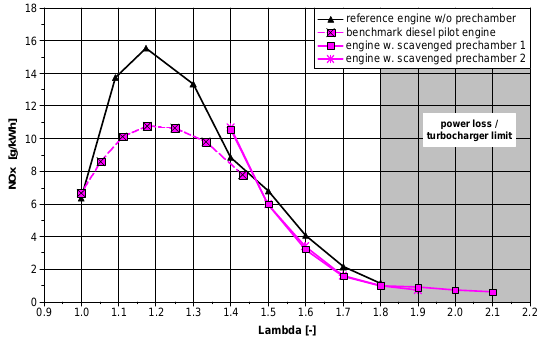
Fig. 19. Raw NO x emissions for the operating point 2 (2000 rpm/220 Nm)